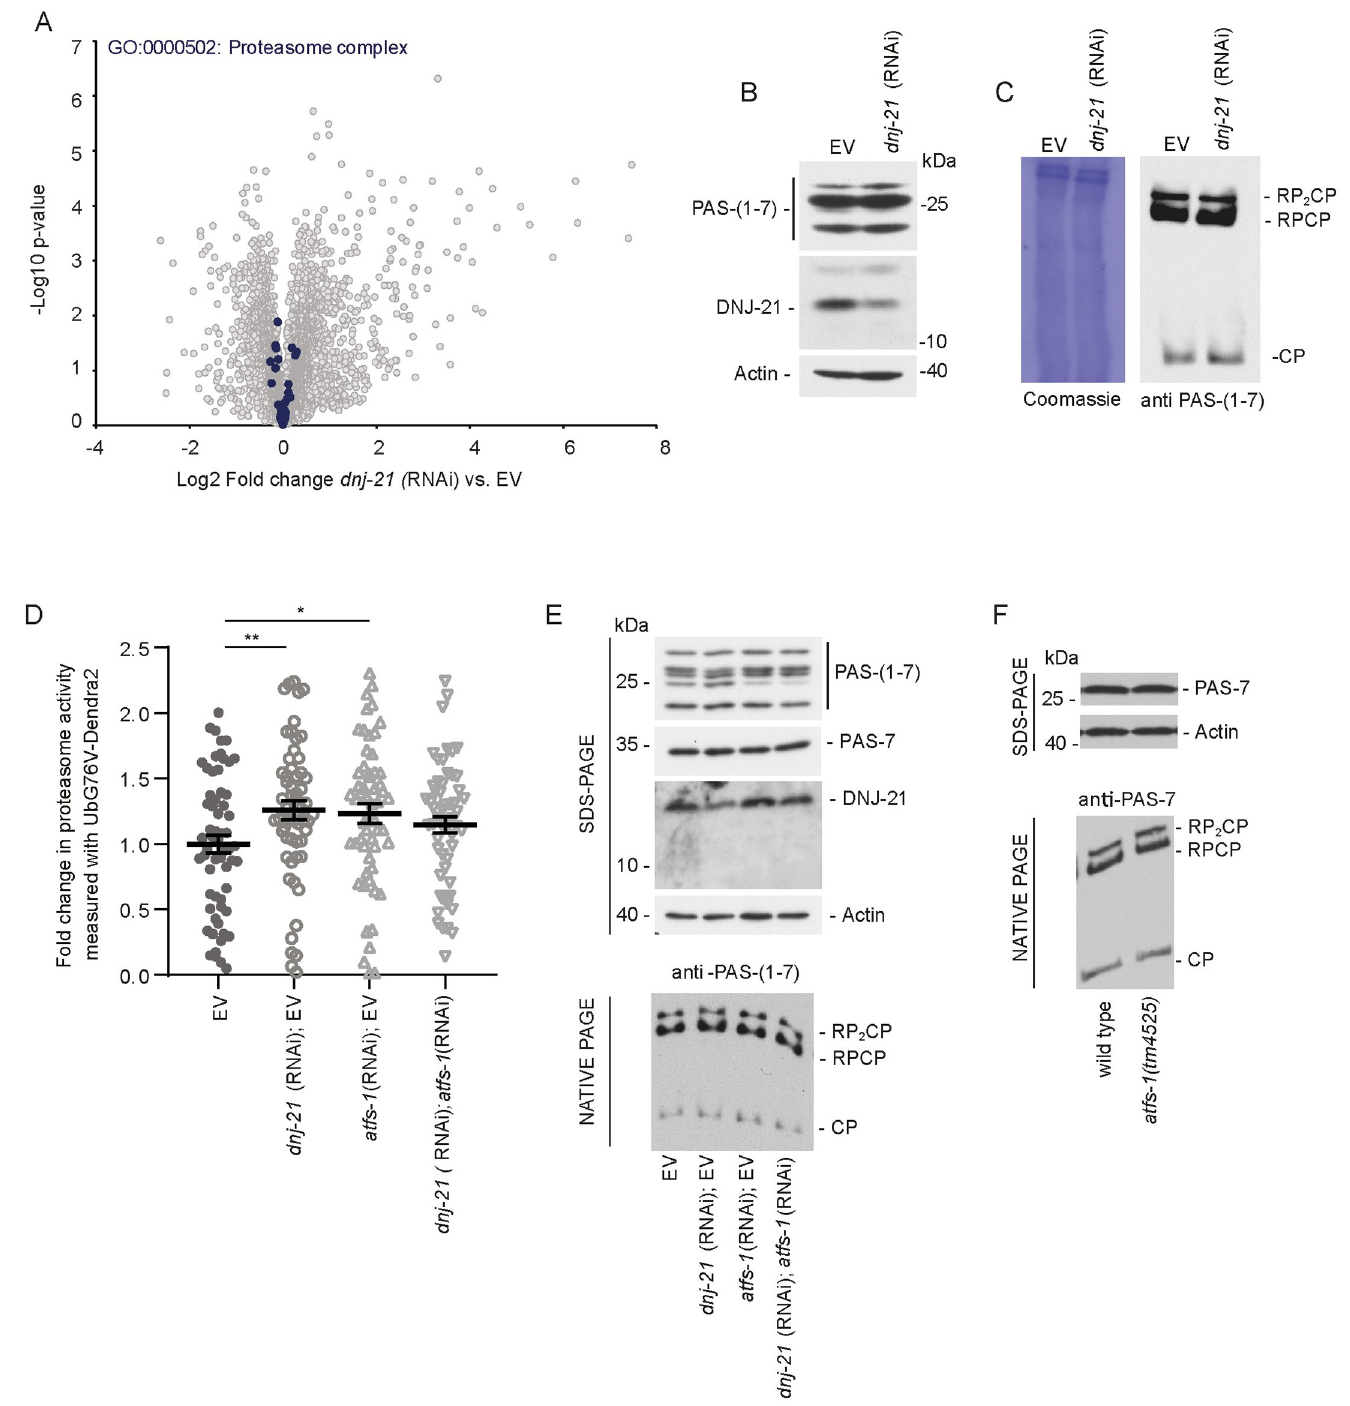
Fig 6. Proteasome activation upon DNJ-21 depletion partially depends on ATFS-1 function. (A) Distribution of fold change of protein levels filtered by specific GO terms (blue circles). Proteomics data are also presented in S1 Table and PXD023830. (B, C) Wild-type worms were grown on RNAi plates until young adulthood. (B) Total protein lysate was separated by SDS-PAGE and analyzed by western blot. (C) Protein extracts were separated using native PAGE and analyzed by western blot. Coomassie staining of the membrane is shown to demonstrate equal loading of the protein. Western blot analysis was repeated using at least 3 biological replicates. (D) Quantification of proteasomal activity upon the indicated RNAi treatment in worms that expressed UbG76V-Dendra2. Data are presented as mean ± SEM; n = 57–62 ( n indicates the number of worms). Three biological replicates were measured for each condition. � p < 0.05, �� p < 0.01. (E, F) Total protein extracts were separated by native PAGE or SDS-PAGE and analyzed by western blot using specific antibodies. (E) Synchronized worms were grown on agar plates that were seeded with RNAi